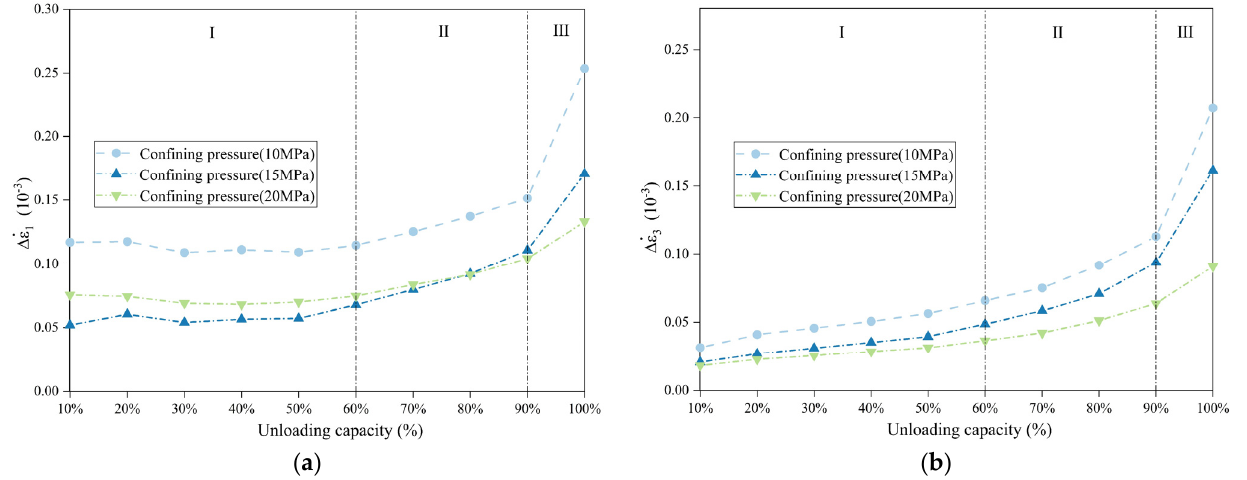
Figure 5. The relationship between the unloading quantity and the strain confining pressure incre- ment ratio. ( a ) Axial strain confining pressure increment ratio. ( b ) Circumferential strain confining pressure increment ratio.